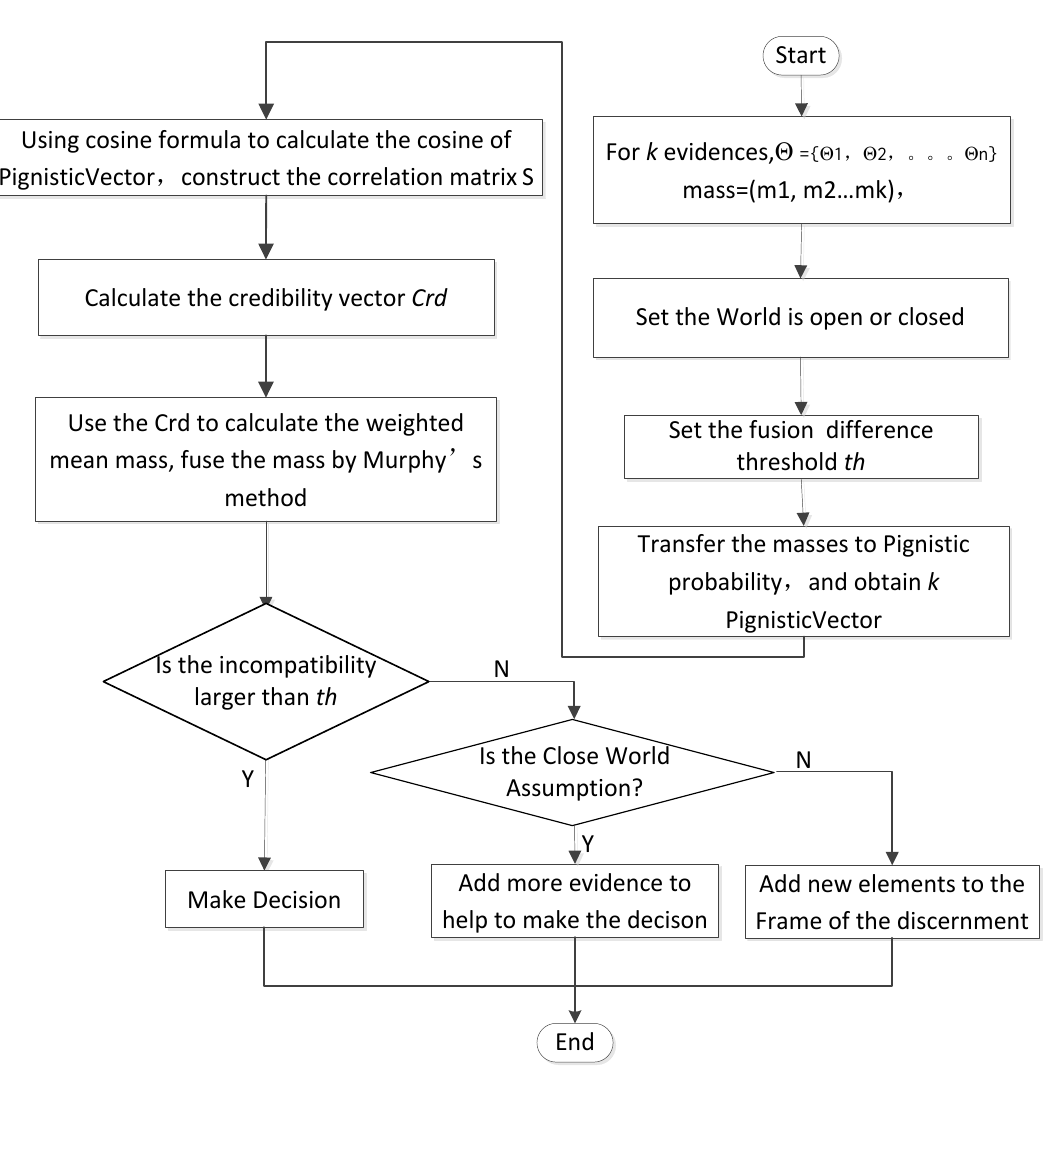
Figure 2. Flowchart of proposed method.